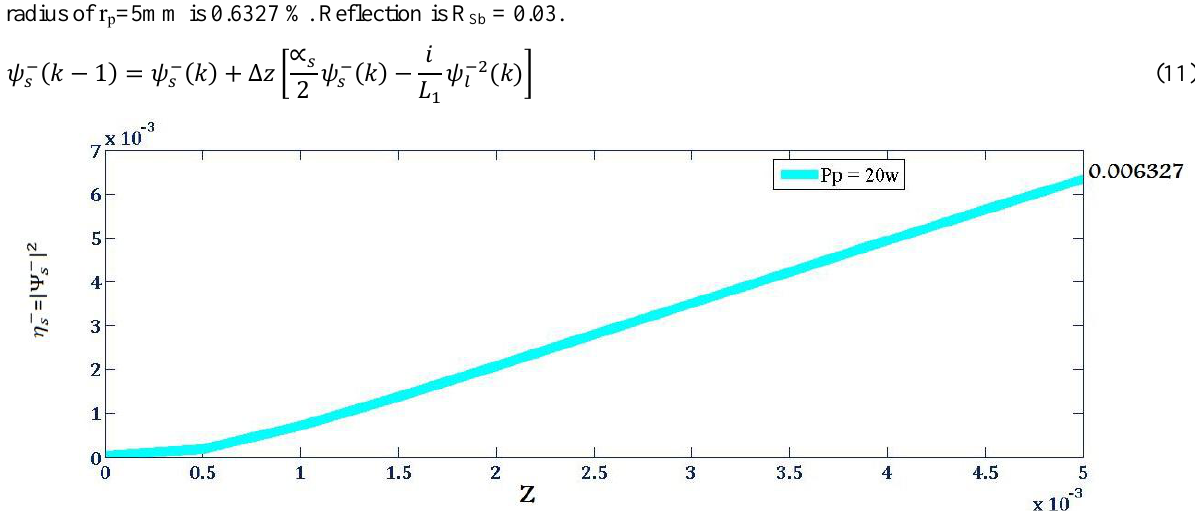
Figure 3. Efficacy of backward second harmonic beam along z-direction (path